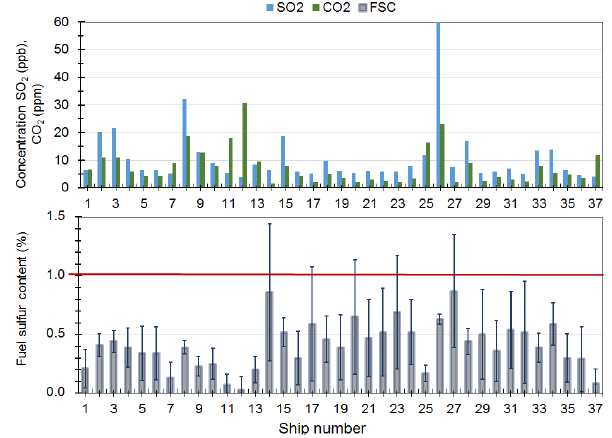
Figure 14. Peak height concentrations of SO 2 and CO 2 from a ship emission plume, and calculated FSCs with the expanded uncertainty U FSC during a short time period for the 2012 measurements. The red line represents the FSC = 1% limit. All of the ships complied with the